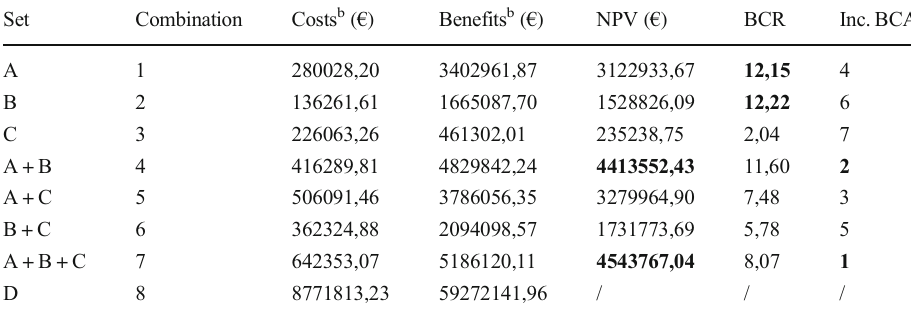
Table 4 Site PP1. Economic assessment of the different project alternatives